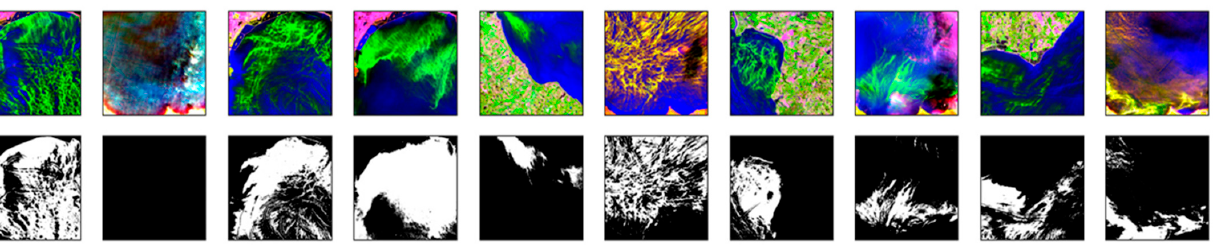
Figure 8. Examples of partial images of the CyanoHABs training set (sub-images and sub-labels). The first line indicates the 10-band input images displayed in false color synthesis (shortwave infra- red − near infrared − red). The green and yellow parts represent the CyanoHABs. The second line are the labels corresponding to the input images. The white part represents the CyanoHABs, with a value of 1, and the black part is the background, with a value of 0.